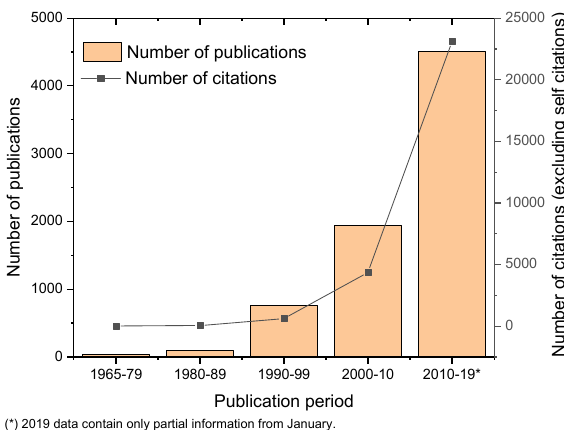
Figure 1. The number of publications on corrosion of steel in concrete in recent decades. The data were obtained using a Boolean search on the Web of Science (ISI) with the following criteria for the title of the publication: (“corrosion”) AND (“concrete” OR “mortar” OR “paste” OR “pore solution” OR “cement” OR “cementitious”) AND (“steel” OR “rebar” OR “reinforcement” OR “reinforcing